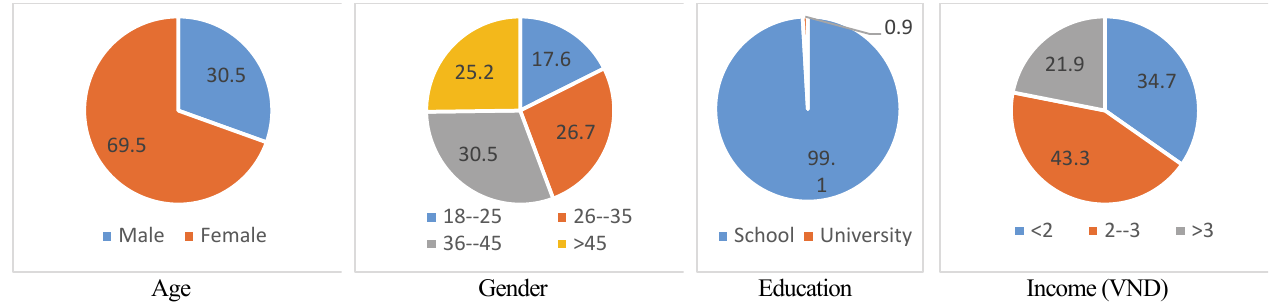
Scale Mean if Item Scale Variance if Item Deleted Deleted